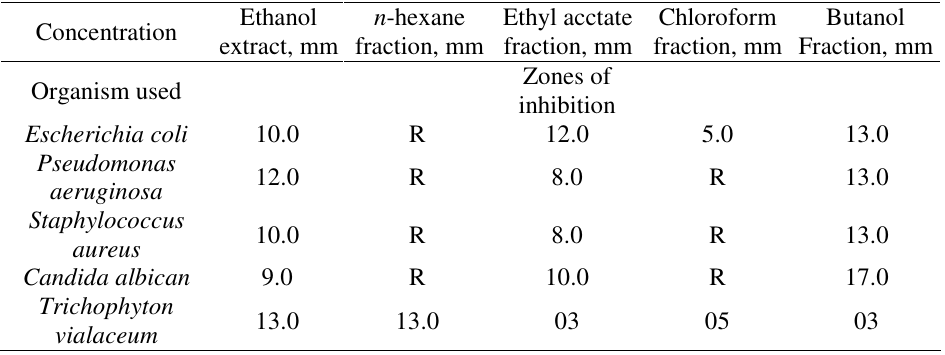
Table 2. Effect of the Achornea cordifolia leaf extracts of different solvent fractions on the zone of inhibition of test microorganisms.